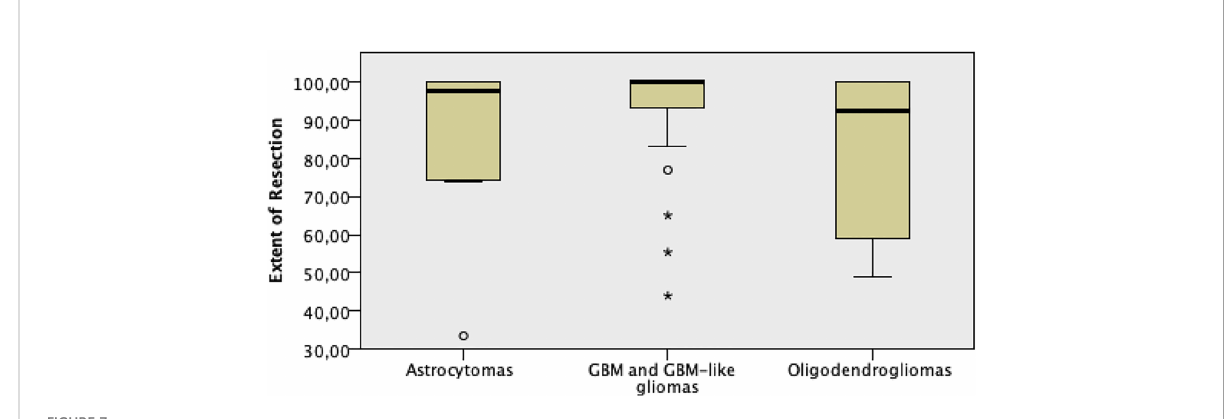
FIGURE 7 EOR comparison among the different molecular subtype gliomas.